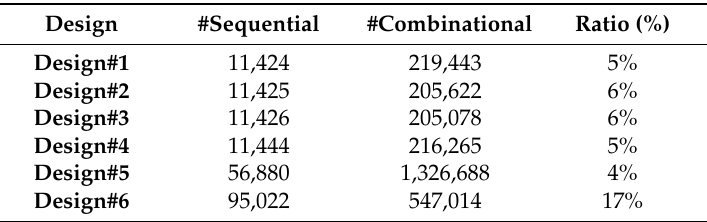
Table 4. Ratio of sequential vs. combinational